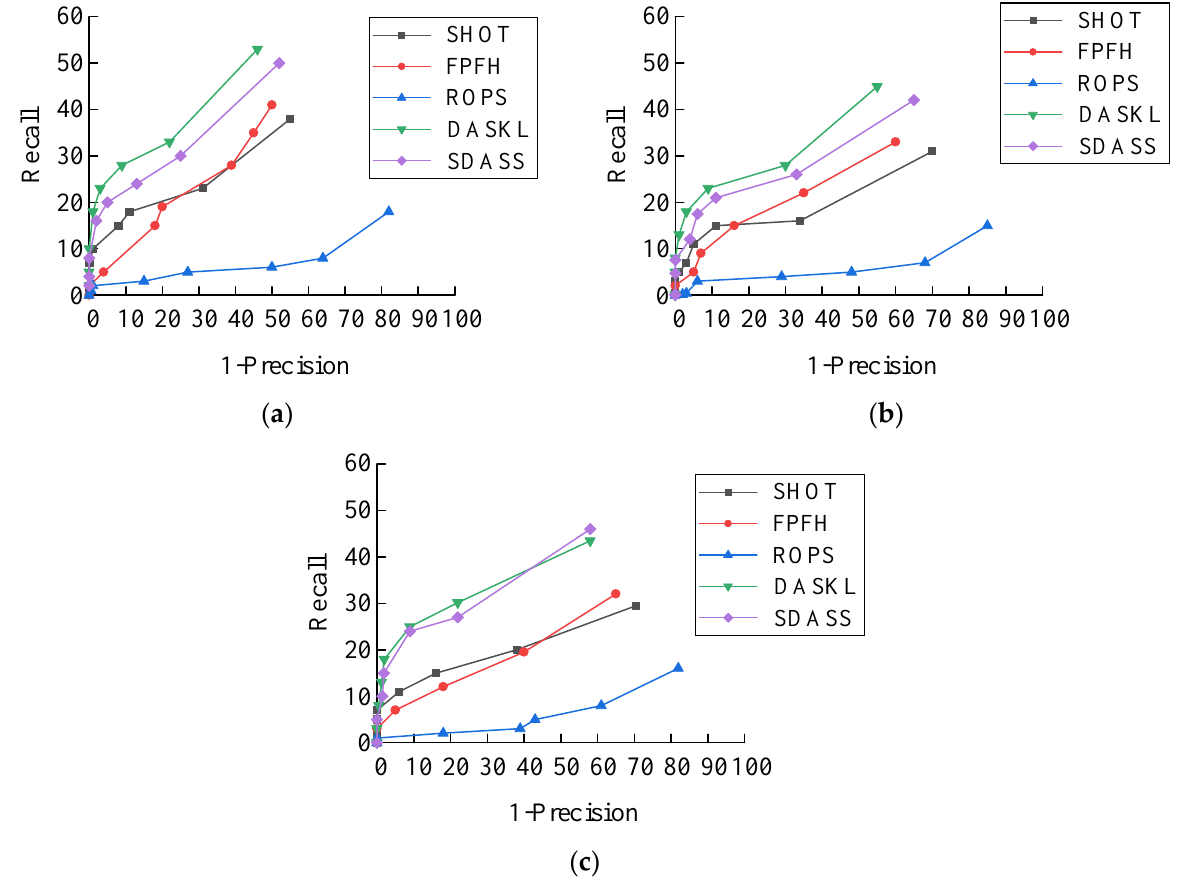
Figure 9. Comparison of matching performance under different occlusion ( a ) Occlusion 60 – 70%. ( b ) Occlusion 70 – 80%. ( c ) Occlusion 80 – 90%.